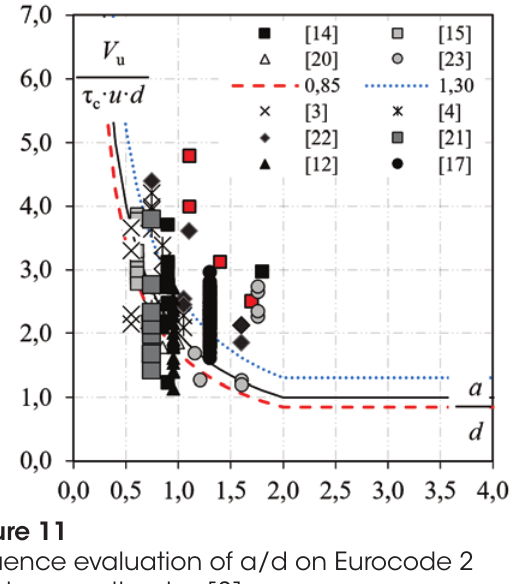
Figure 11 Influence evaluation of a/d on Eurocode 2 resistance estimates [2]